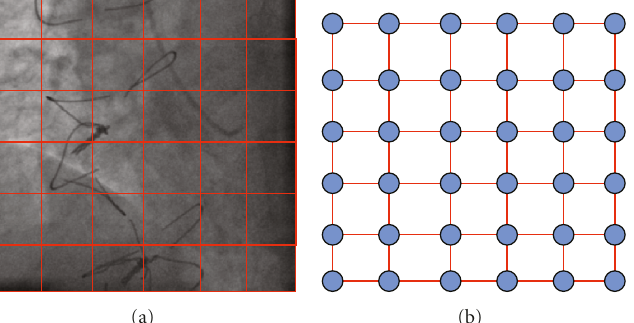
Figure 3: MRF framework. (a) A processed image divided in blocks (36 blocks for the sake of clarity of the figure). (b) The graph associated with the introduced Markov model. The sites are plotted in blue and their neighbouring relations are drawn in orange.